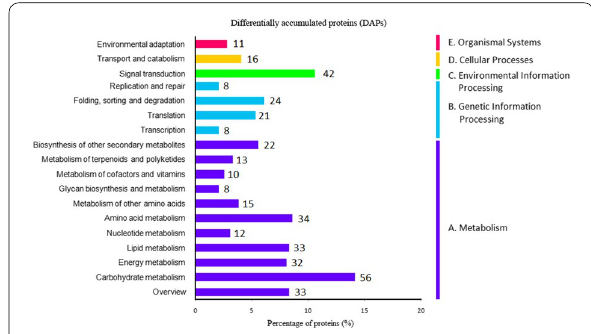
Fig. 5 KEGG annotation of the differentially accumulated proteins